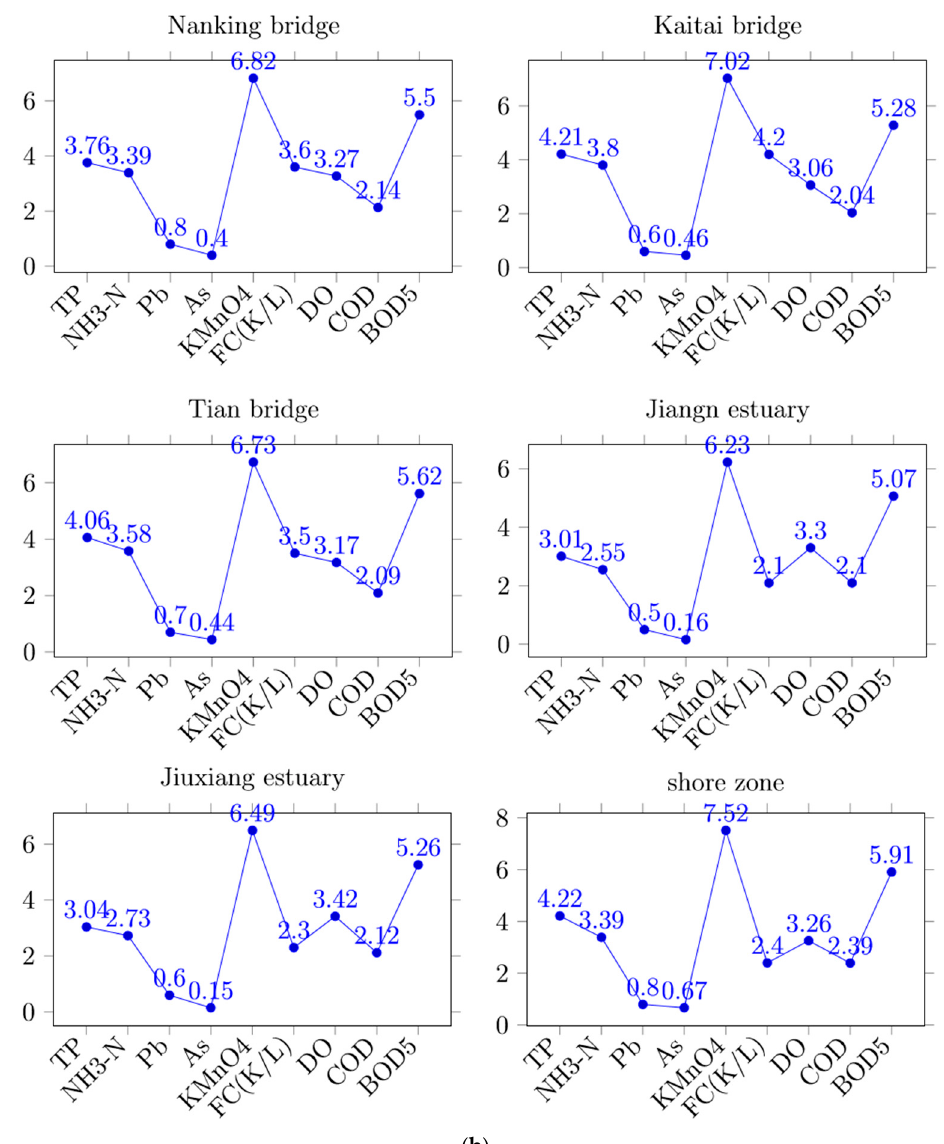
Figure 4. ( a ) River section illustration, ( b ) River section illustration. Note that, since the measured values of different factors have large difference, some measured values are converted into a multiple form to make the contrast effect more